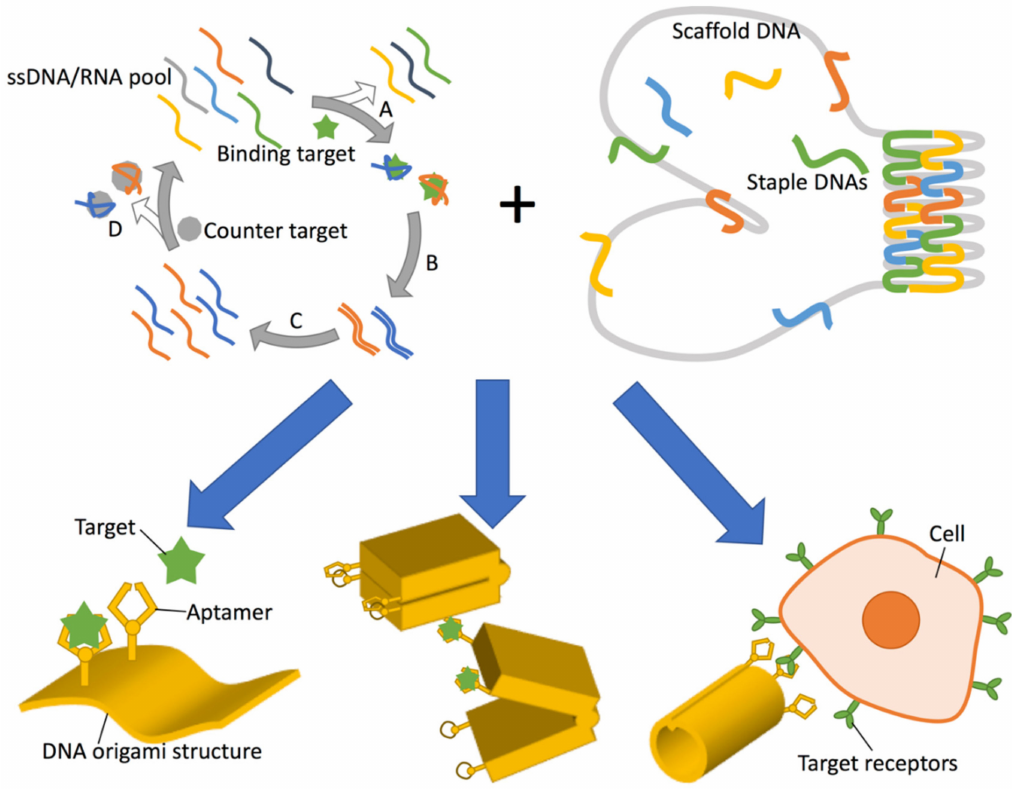
Figure 1. Applications of DNA aptamers when combined with DNA origami. ( Top left ) Schematic of the SELEX (Systematic Evolution of Ligands by EXponential enrichment) process. First, a fraction with target (green star) affinity is extracted from an initial ssDNA (single-stranded DNA)/RNA pool ( A ) and amplified by (reverse transcription and) PCR amplification ( B ). The reverse sequences are removed or forward sequences are transcribed to prepare an enriched ssDNA or RNA library, respectively ( C ) and occasionally counter selection is inserted to remove non-specific binding fractions according to affinity for the counter target (grey circle) ( D ). The selected fraction is used as the second-generation library for the next round of selection ( A ). ( Top right ) A schematic illustration of DNA origami assembly. A long ssDNA (grey) is folded by hundreds of short ssDNA (coloured) by designed hybridization. Bottom : Combination of aptamer and DNA origami (yellow) can result in: ( Bottom left ) protein nanoarray and biosensor construction via capture of target protein (green) by the aptamer arm; ( Bottom center ) Target dependent mechanical transformation by aptamer-lock or split aptamer integration for either biosensing or molecular computing; and ( Bottom right ) specific cell targeting for drug delivery and targeted therapy e.g., by utilising cancer cell targeting